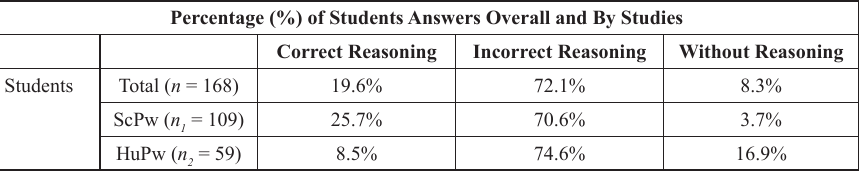
Table 2. Students’